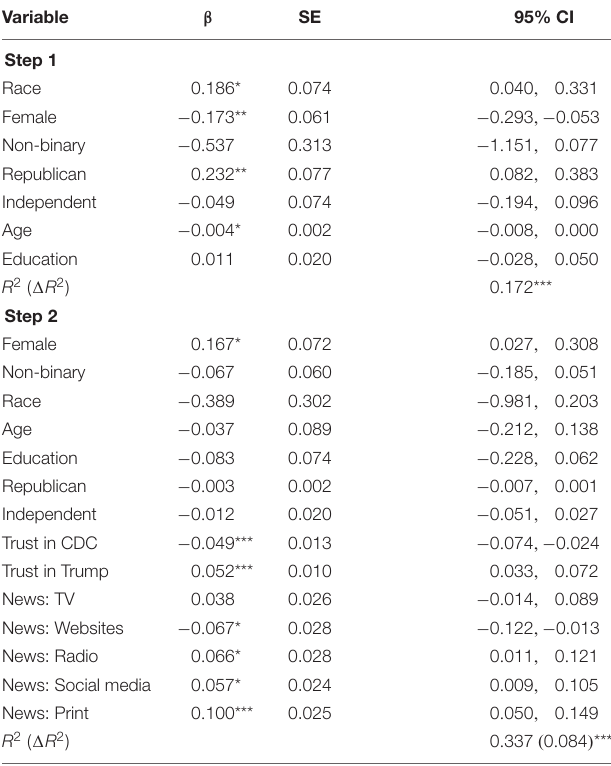
TABLE 3 | Regression analyses predicting negative attitudes toward Asian Americans in response to